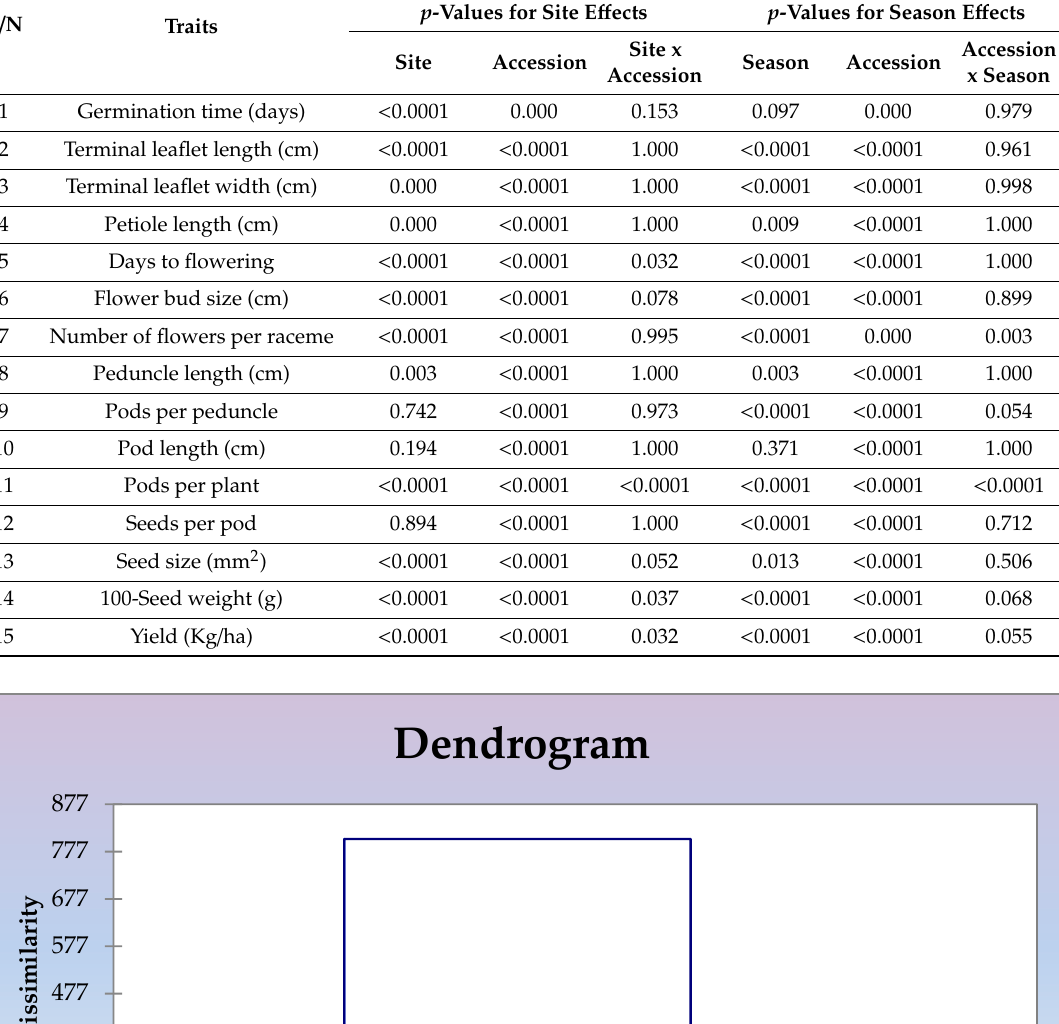
Table 5. Two-way analysis of variance for the interactions due to the site and season for the studied quantitative traits.